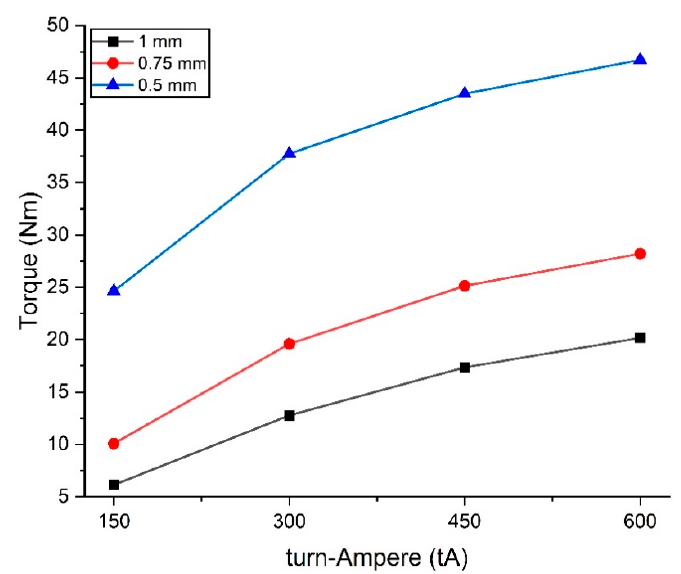
Figure 15. TVMRB torque achievement in each variation.